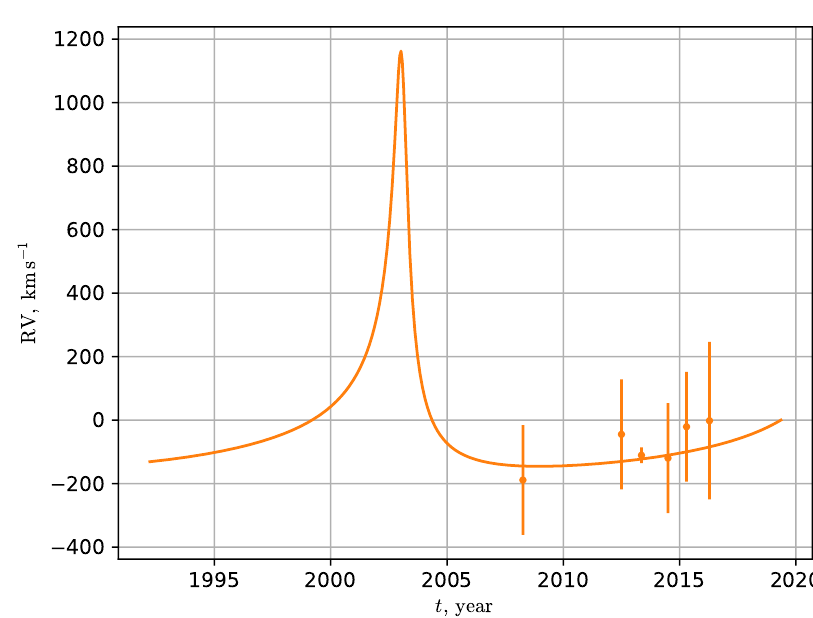
Figure 5. The RV plot of best-fit PPN orbit of